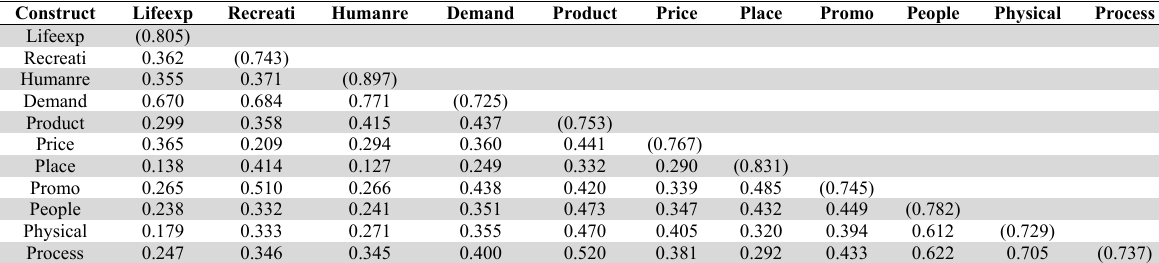
Note: Square roots of average variances extracted (AVE S ) shown on